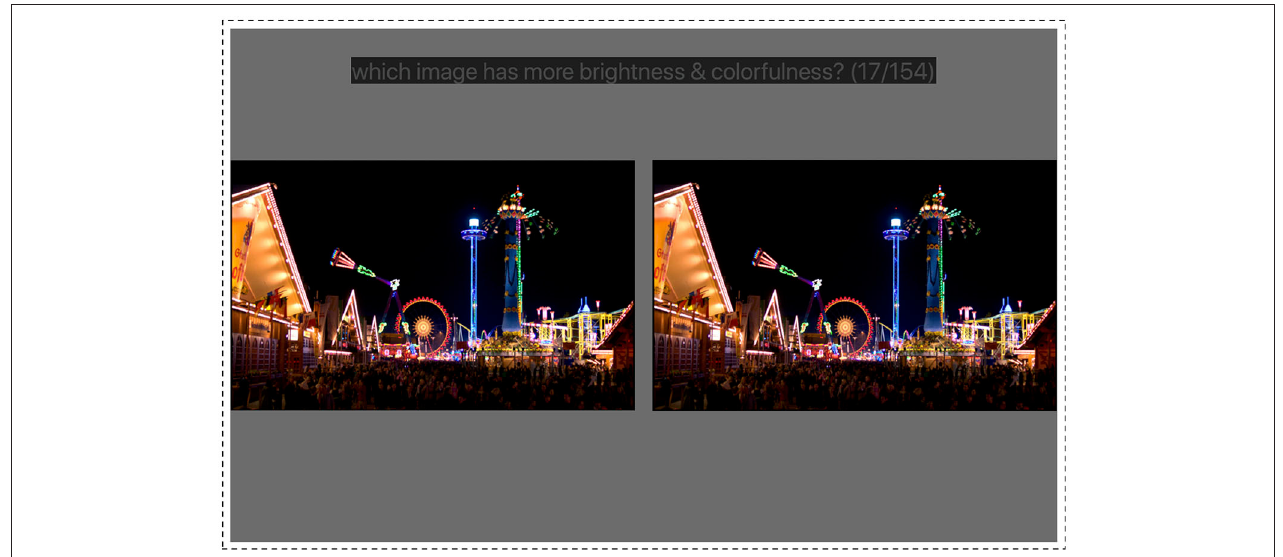
FIGURE 2 | Stimulus configuration where the observers saw two images side-by-side and was asked to select the one with higher brightness and colorfulness. The background is a uniform gray at 100 nits surrounded by a thin white border of 500 nits. Source: image stimuli from the dataset in ( Froehlich et al.,